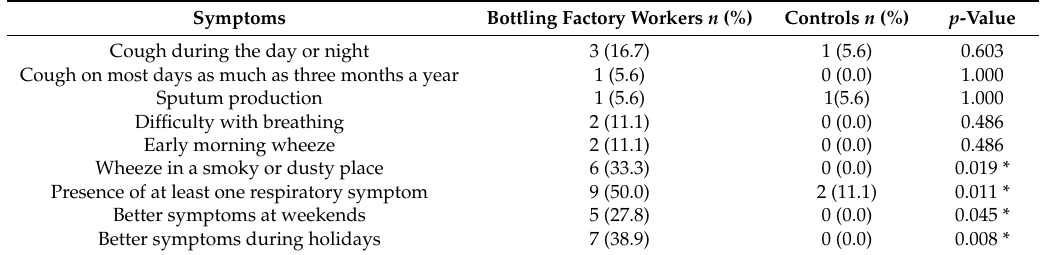
Table 2. Respiratory Symptoms among Bottling Factory Workers and